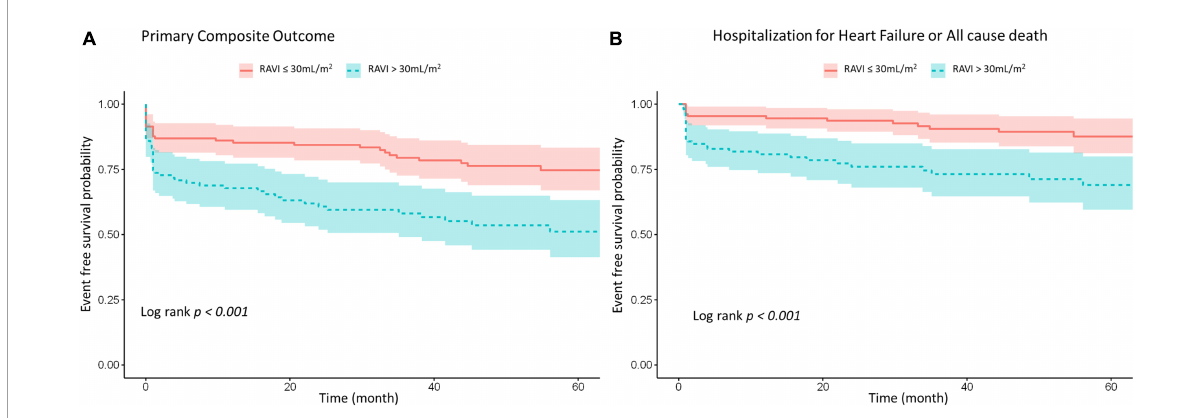
FIGURE2 Kaplan–Meier survival analysis for (A) primary composite outcome of HHF, stroke, systemic embolism or all cause death and (B) composite of HHF or all cause death according to RA size. HHF, hospitalization for heart failure; RA, right atrium; RAVI, right atrial volume index.